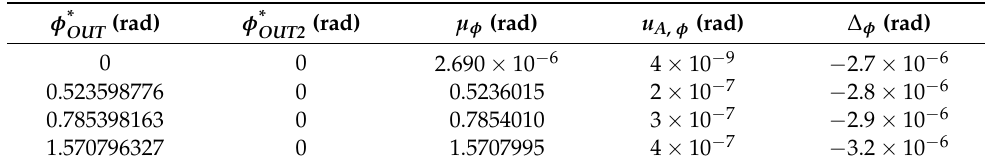
Table 10. Phase displacement characterization